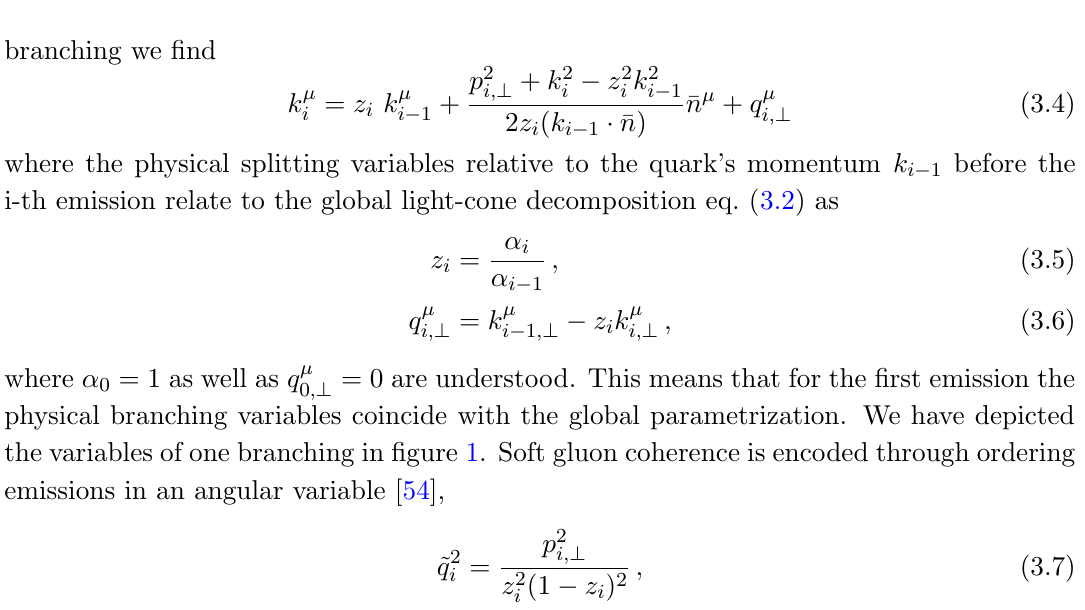
Figure 1. A gluon branching o(cid:11) a back-to-back quark/anti-quark system. The radiated gluon z of the parent’s momentum and is emitted at a transverse is assumed to carry a fraction 1 (cid:0) momentum which equals the one acquired by, in this case, the anti-quark after the